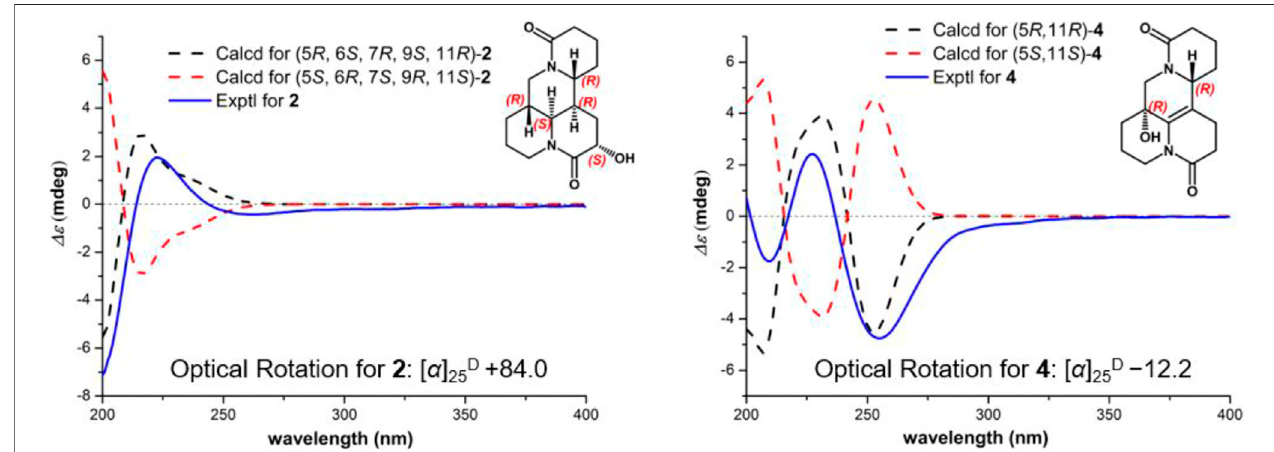
FIGURE5| ExperimentalECDandcalculatedspectraof2and4attheB3LYP/6 – 31+G(d)level[2: σ (cid:1) 0.30 eV,UVshift (cid:1) − 5 nm;4: σ (cid:1) 0.30 eV,UVshift (cid:1) − 6 nm].